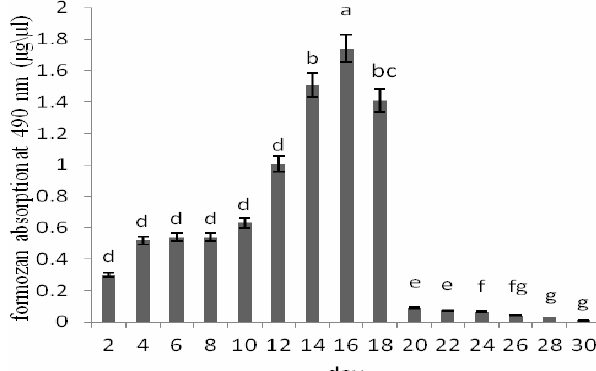
Fig. 11. The light brown calli obtained from 0.1 mg/L NAA and 2 mg/L BAP (A); white calli obtained from 0.5 mg/L NAA and 0.5 mg/L BAP (B) which was selected for suspension culture